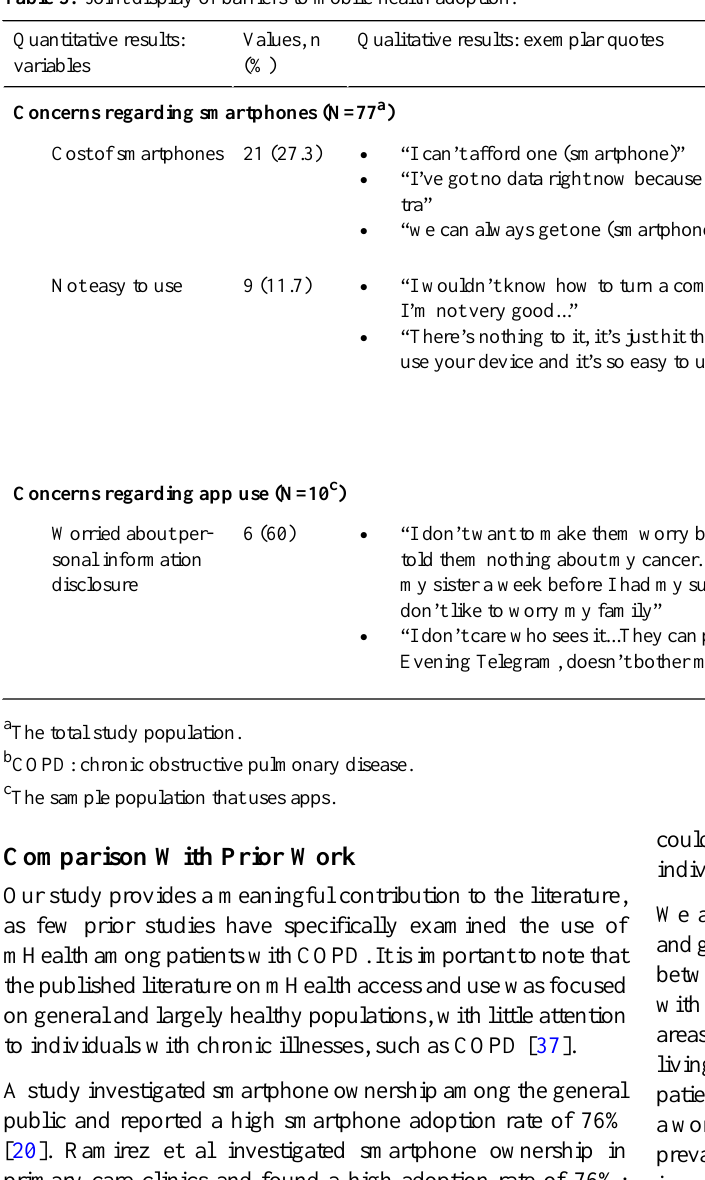
Table 5. Joint display of barriers to mobile health